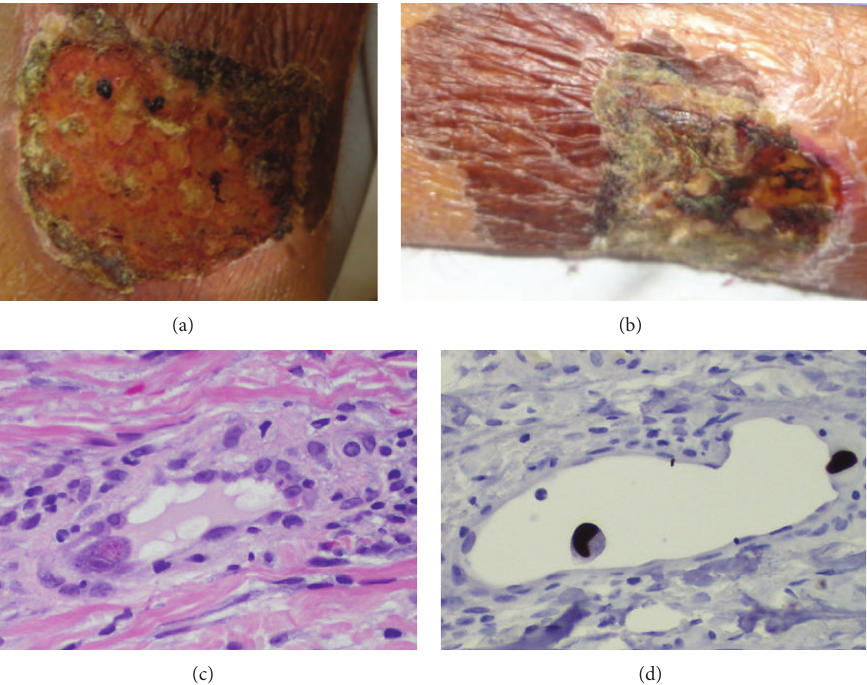
Figure 1: (a) Lower leg ulcer on admission, (b) lower leg ulcer after five days of ganciclovir treatment, (c) H&E staining showing cytoplasmic and nuclear inclusions characteristic of CMV infection, and (d) immunohistochemistry staining for